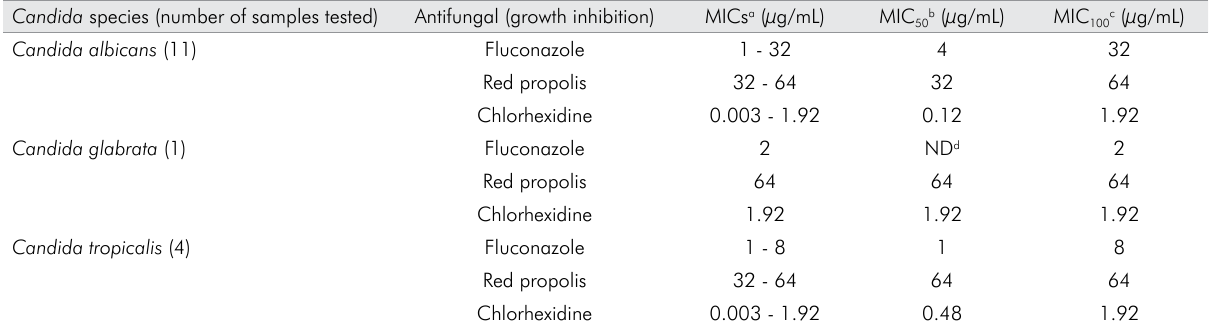
Table 1. Mean results of fungistatic activity of fluconazole, red propolis alcoholic extract and chlorhexidine against Candida species isolated from cases of chronic